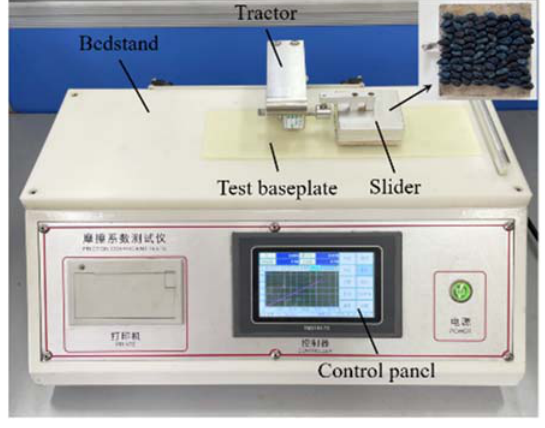
Figure 2. Static friction coefficient measuring device.